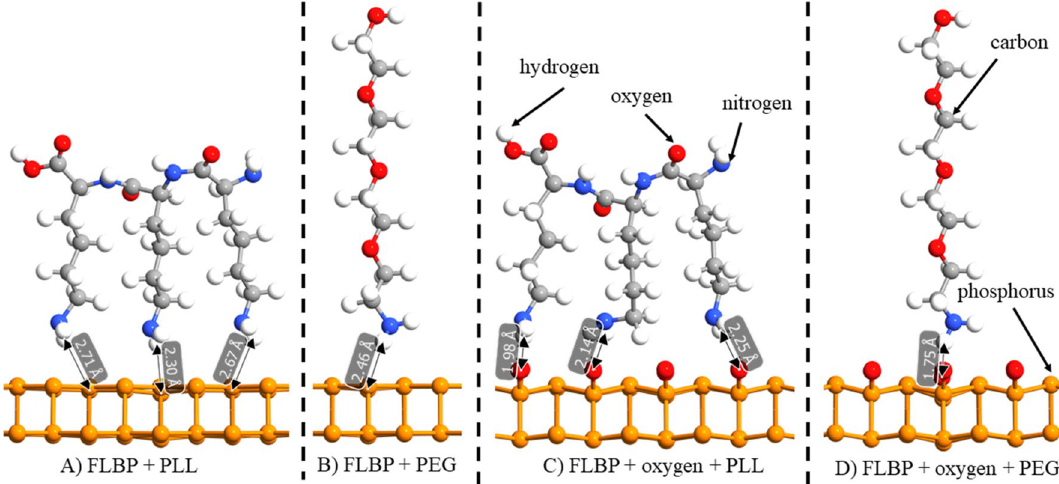
Figure 7. Oxidised and non-oxidised surfaces of FLBP with different linkers: ( a ) non-oxidised with PLL, ( b ) non-oxidised with PEG, ( c ) oxidised with PLL and ( d ) oxidised with PEG as linker [drawn with QuantumATK Q-2019.12 (https:// www. synop sys. com/ silic on/ quant umatk/ resou rces/ relea se- notes. html)]. Substrate PLL (kcal mol −1